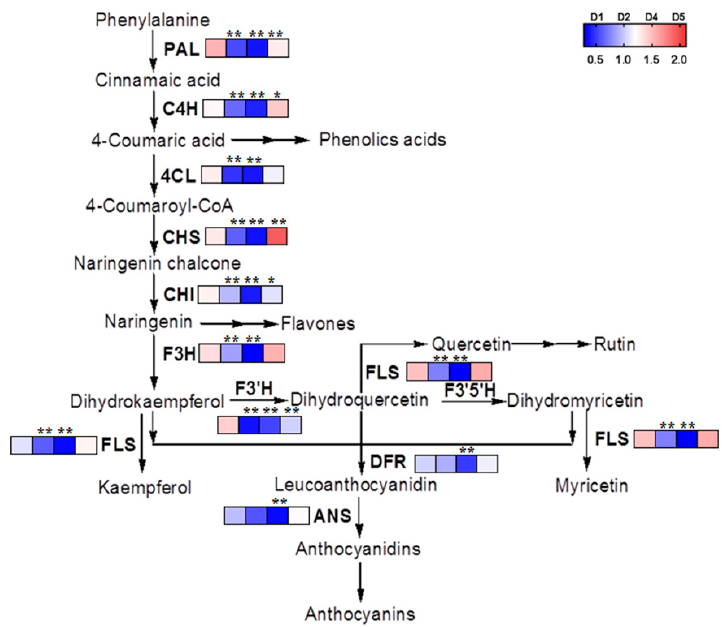
Figure 7. Expression of the key genes in phenylpropanoid biosynthetic pathway of tartary buckwheat in response to salt stress. PAL, phenylalanine ammonium lyase; CHI, chalcone isomerase; CHS, chalcone synthase; 4CL, 4-coumarate-CoA ligase; C4H, cinnamic acid 4-hydroxylase; F3H, flavanone-3-hydroxylase; F3 ′ H, flavonoid-3 ′ -hydroxylase; FLS, flavonol synthase; DFR, dihydroflavonol reductase; ANS, anthocyanin synthase. The asterisk indicates a significant difference between control (Con.) and salt-treated (Tr.) samples (*, p < 0.05; **, p < 0.01).